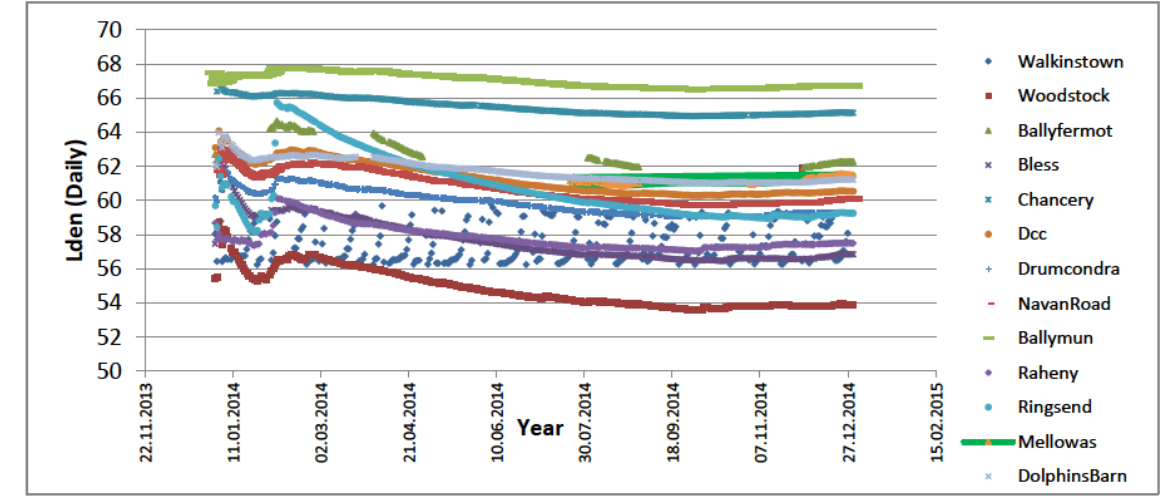
Supplementary Figure 2: L den at daily resolution